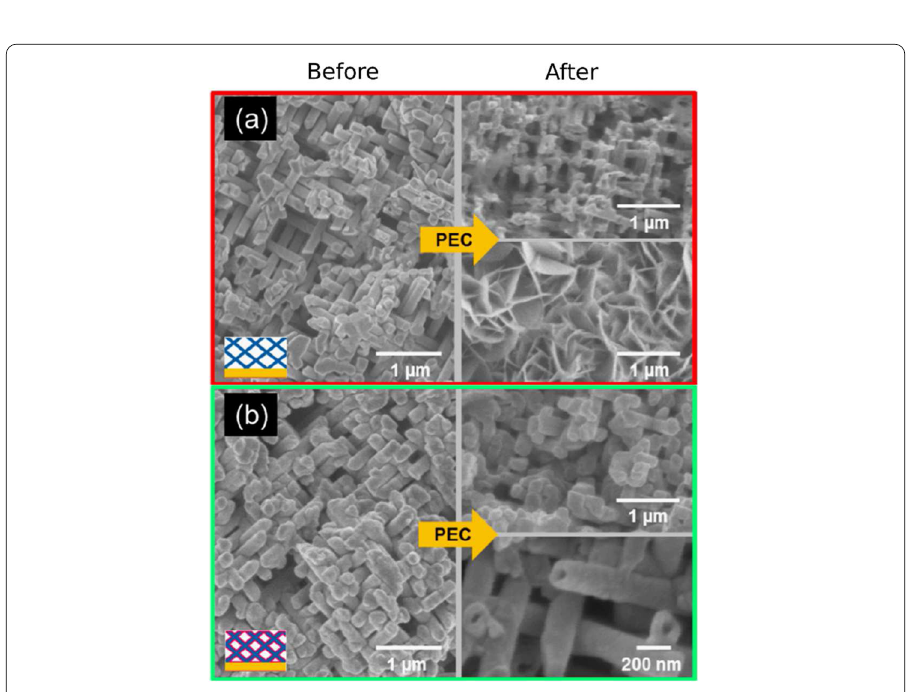
Figure 4 SEM images of ZnO nanowire networks with and without a TiO 2 protection layer after photoelectrochemical experiments. ( a ) After one hour of reaction, the nanowires decay and recrystallization of ZnO occurs. ( b ) After three hours of photocorrosion, the network coated with TiO 2 shows no or only small corrosion effects. From L. Movsesyan et al., ©Nanomaterials 8, 693